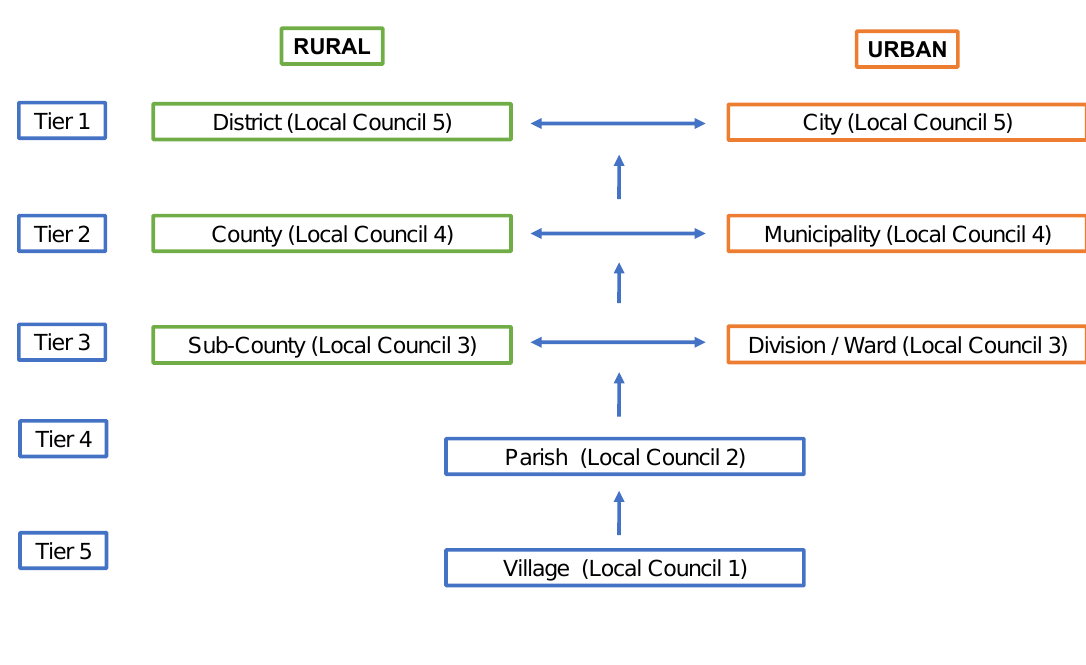
Figure 1: Uganda's five-tier local governance